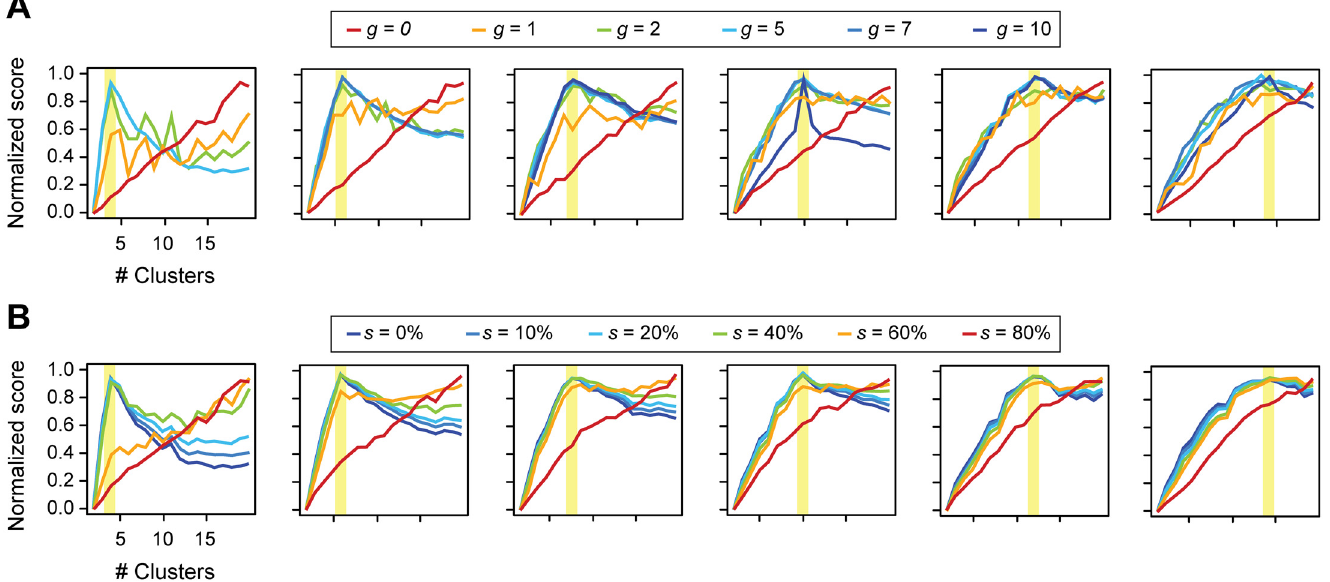
Fig 4. The effects of completeness/accuracy of known kinase-substrate annotations on CLUE's performance. CLUE's performance as a function of number of kinases annotated to have substrates in g out of the k clusters. The panels (from left to right) show six scenarios with true number of true simulated clusters highlighted in yellow. The scenario g = 0 resembles the situation when no existing knowledge is available for use by CLUE. CLUE's ability to accurately predict the true number of clusters improves dramatically as g increases. CLUE's performance as a function of percentage of incorrect kinase- substrate annotations (noise). We set g = 5 for testing different levels of noise (denoted as s ). The panels (from left to right) show six scenarios with true number of true simulated clusters highlighted in yellow.